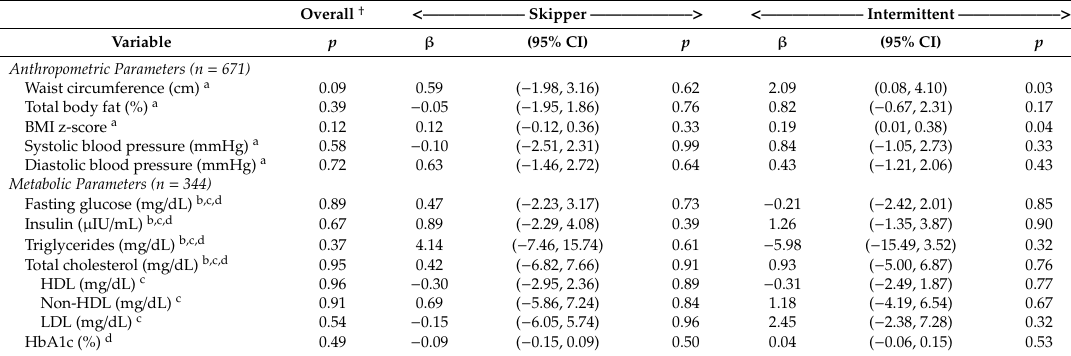
Table 3. Multivariate regression models of anthropometric and metabolic parameters with regular consumers as the referent